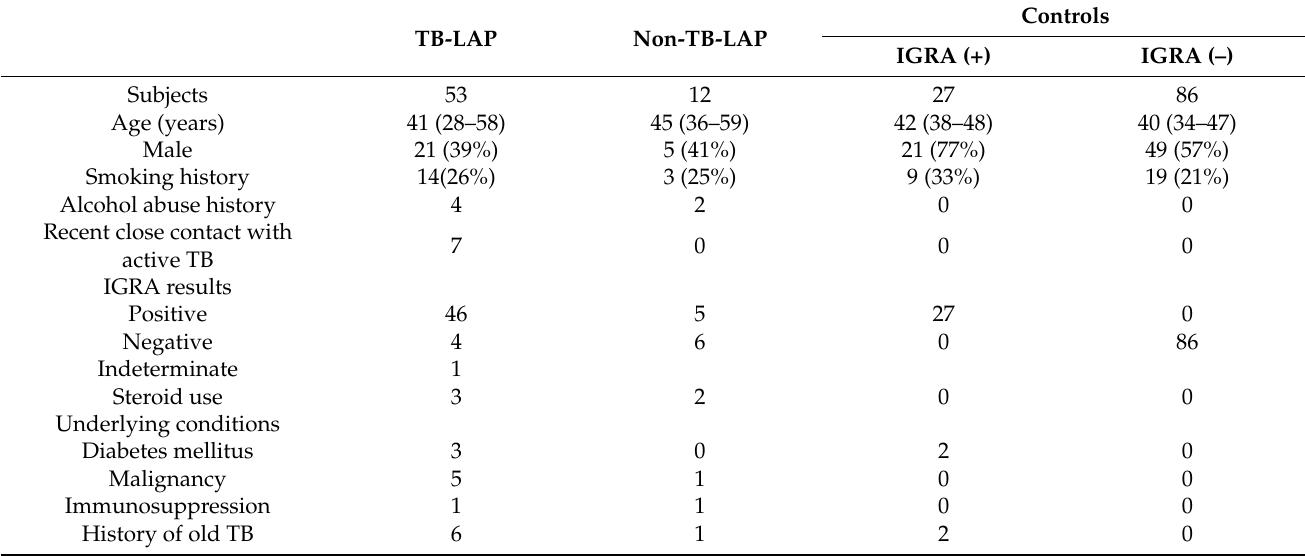
Table 2. Characteristics of the study